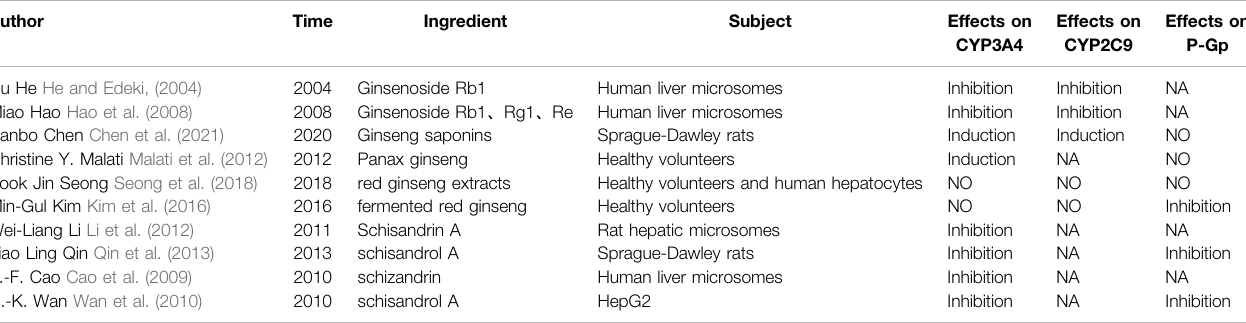
TABLE 4 | Studies about effects of main components in SMI on CYP3A4, CYP2C9 and P-gp. HepG2, Human Hepatoellular Carcinomas; Caco-2, Human Colon Adenocarcinoma Cell Line; NA, no